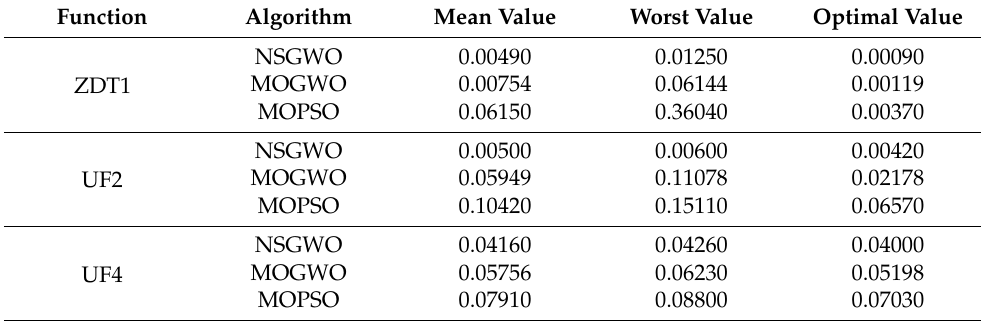
Table 2. GD values of optimization results for benchmark